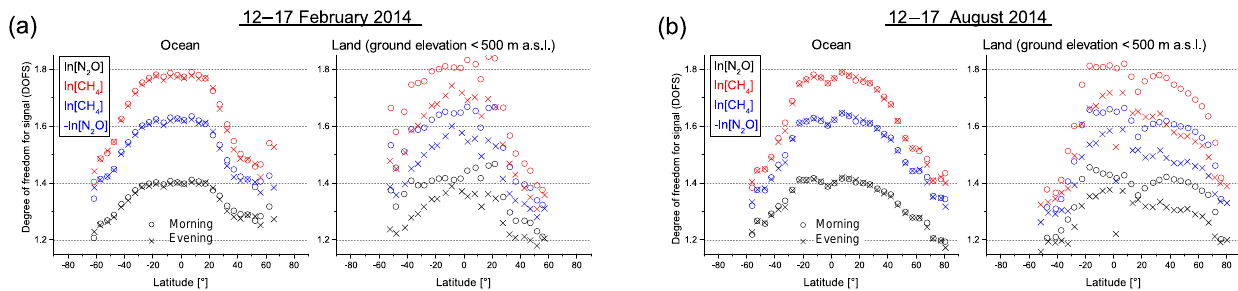
Figure 3. Latitudinal cut of the DOFS values of the ln [ N 2 O ] (black dots), ln [ CH 4 ] (red dots) and ln [ CH 4 ]− ln [ N 2 O ] (blue dots) products for the IASI morning and evening overpasses ( ≈ 09:30 and 21:30 Local Solar Time, respectively): (a) for mid-February 2014 and (b) for mid-August 2014. The latitudinal cuts are shown separately for observations over ocean and land (only if ground altitude <